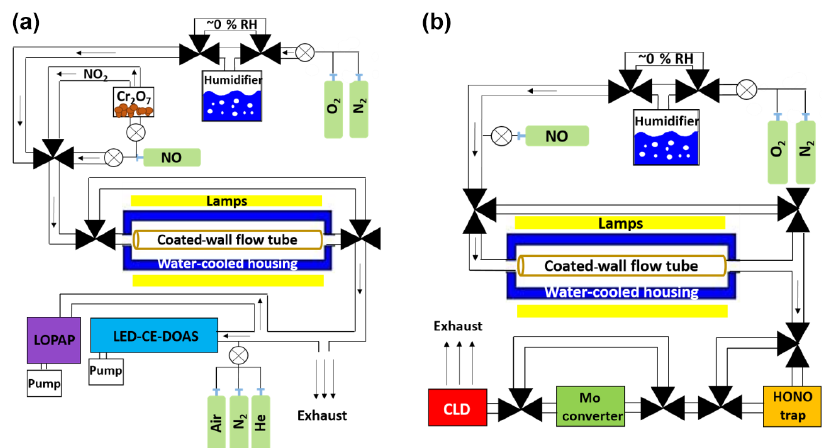
Figure 1. Sketch of the photochemical flow tube reactor setups at PSI for (a) Setup 1 in 2013 measuring NO 2 generation and (b) for Setup 2 in 2014 measuring NO